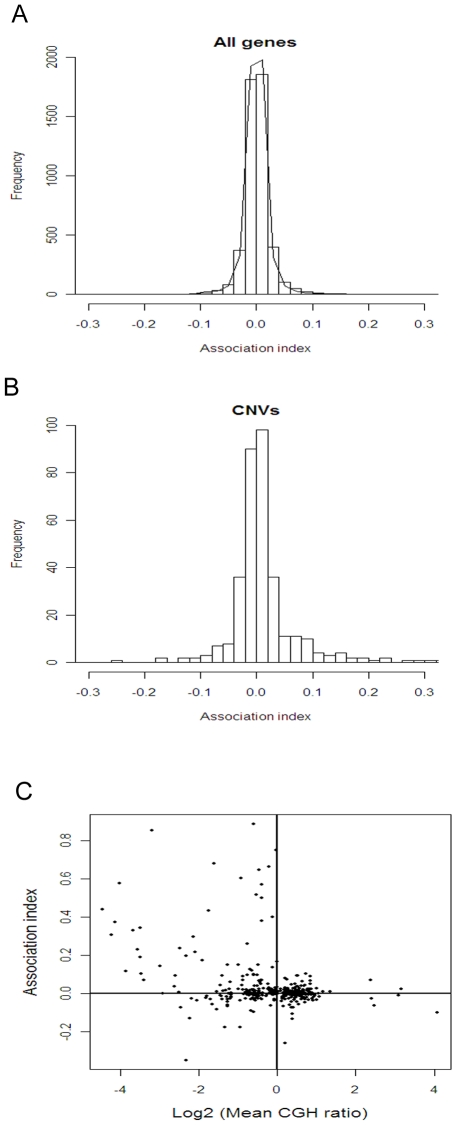
Associations Between Expression Levels and Genomic DNA Content among Field Isolates.Regression coefficients of normalized hybridization signals from cDNA on normalized hybridization signals from gDNA in the 5 field isolates were calculated for each gene. A. The frequency distribution of these coefficients (association index) across all genes was more dispersed than expected by chance (black line, obtained by randomly shuffling the data across isolates within each gene, P<0.001 by Kolmogorov-Smirnov test). B. Genes that showed variation at the genome level (CNVs) had a higher frequency of strong positive and strong negative associations than genes that did not (P<0.001 by Kolmogorov-Smirnov test). C. Genes with reduced genomic content relative to 3D7 had stronger associations, both positive and negative, with expression levels than genes with equivalent genomic content to 3D7. Only data from genes showing significant variation at the genomic level are shown in C.